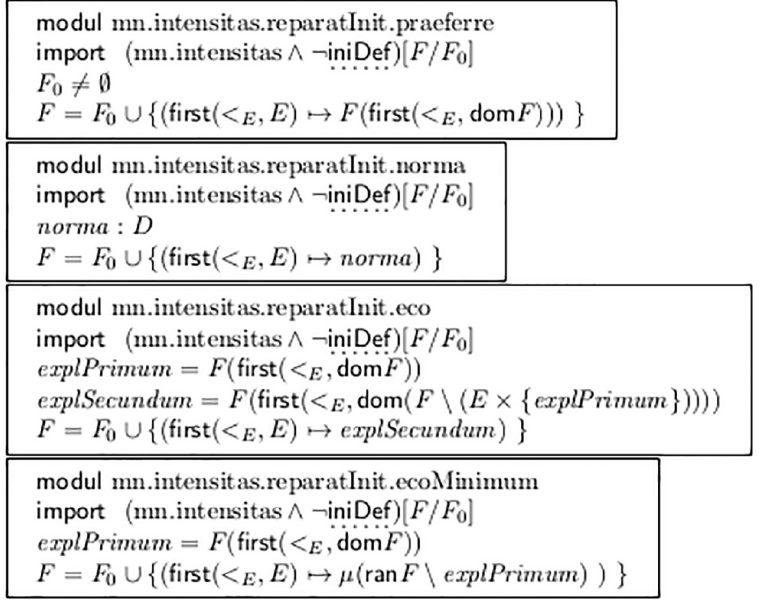
Fig 11. Repairing missing